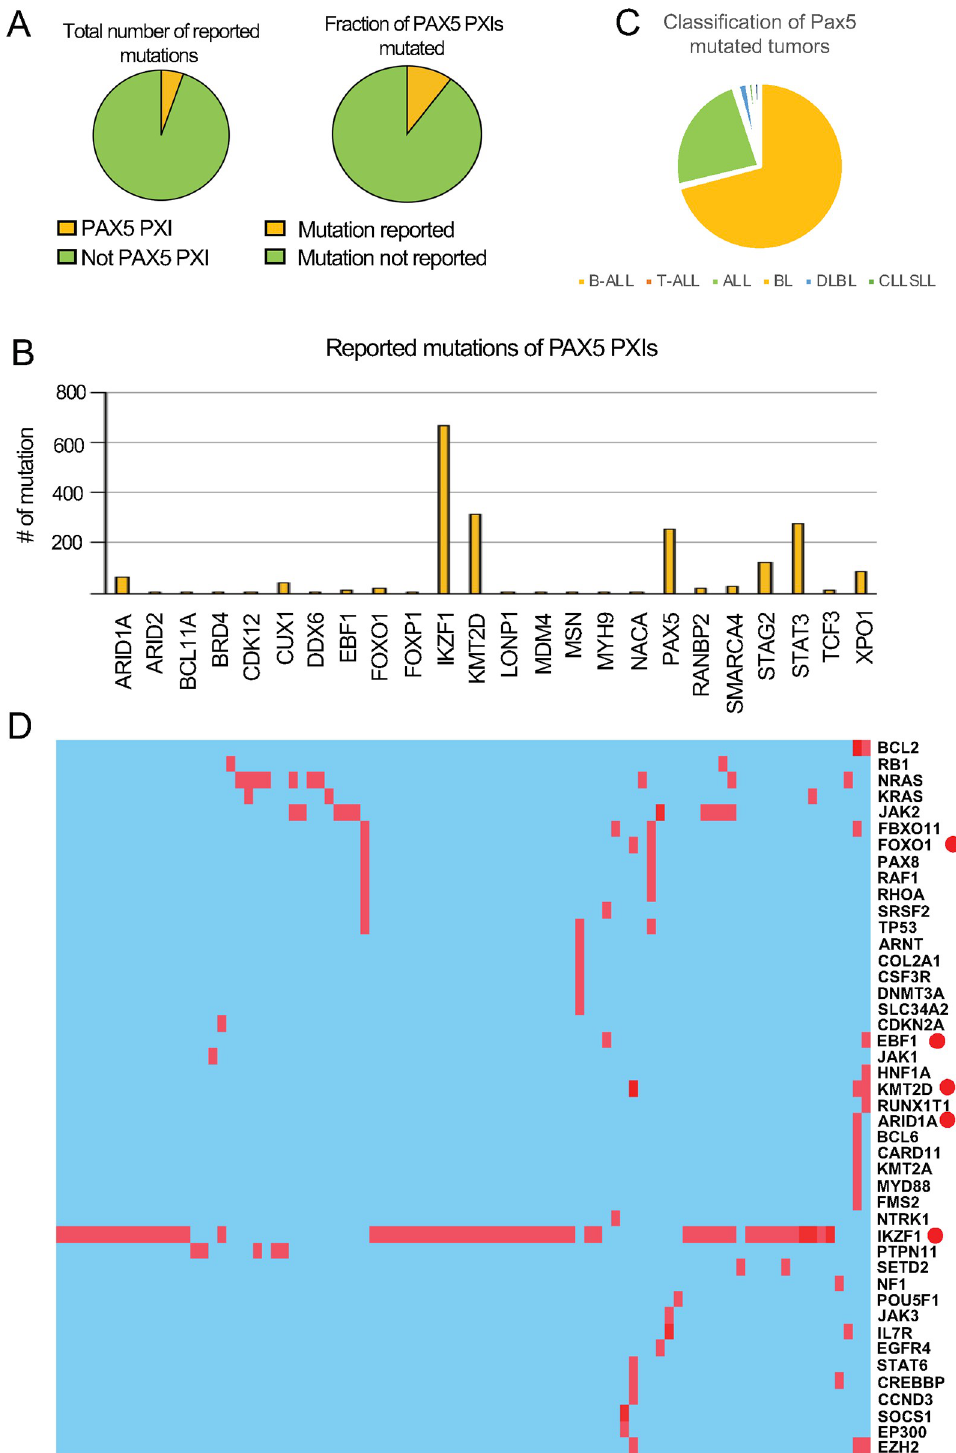
Fig 2. PAX5 PXIs are frequently mutated in combination with PAX5 in human leukemia. (A) Pie charts showing the fraction of PAX5 PXIs (list of 239 entries) found mutated in the public cancer database COSMIC (cancer genes